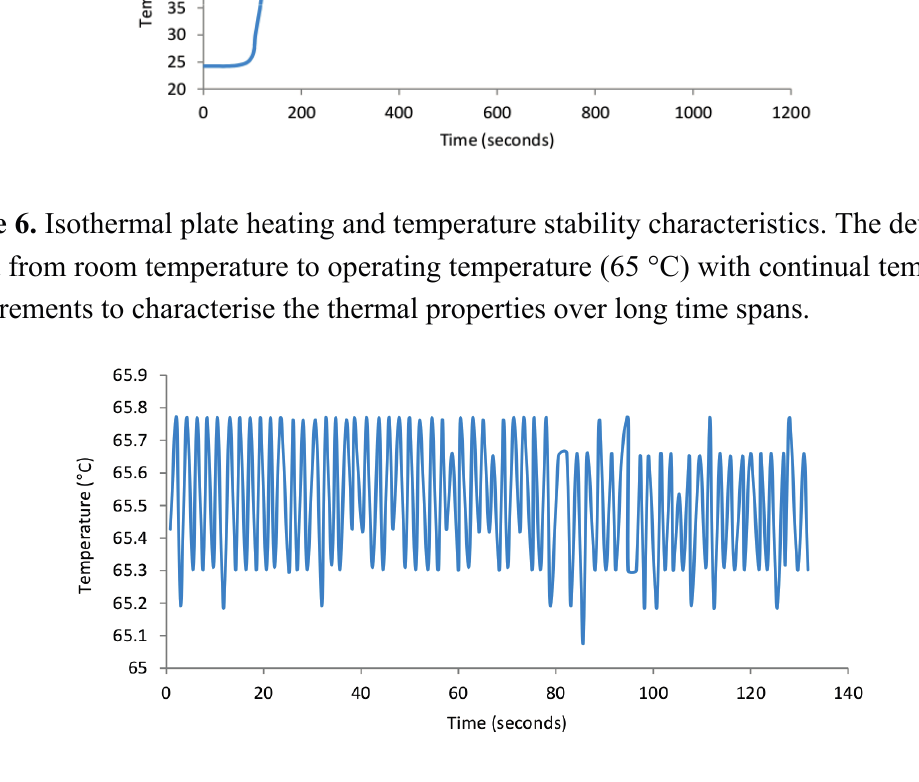
Figure 7. Isothermal plate temperature in high resolution over ~2 min. The device was heated to operating temperature and high resolution temperature measurements were taken from within a filled well to identify the thermal variation over short time